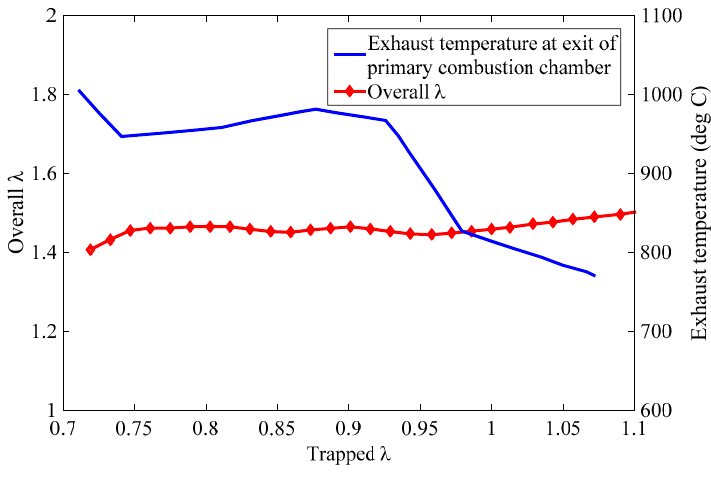
Figure 2. Flame position indication.